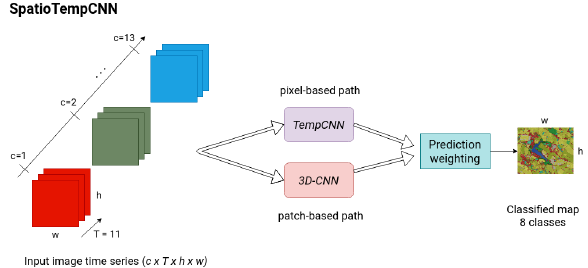
Table 2. Ground truth dataset repartition using